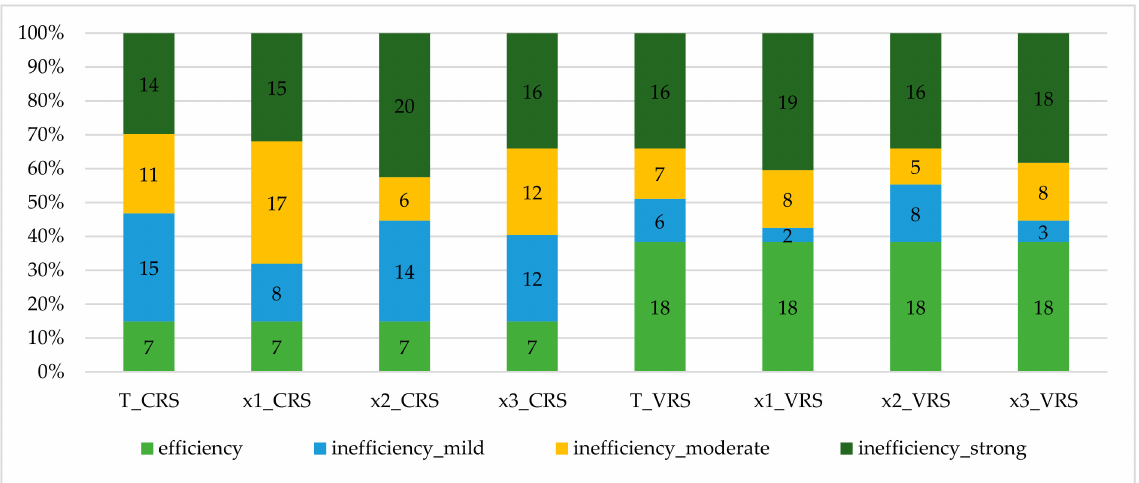
Figure 1. Distribution of the inefficiency rate in the models monitored. CRS: constant returns to scale; VRS: variable returns to scale. T: total efficiency; x1—physicians; x2—nurses; x3—other staff; y1—number of hospitalized patients; y2—number of outpatient examinations; y3—number of